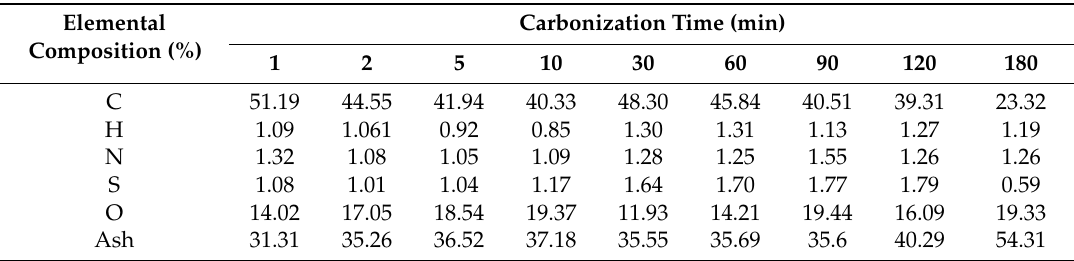
Table 2. Elemental composition of the ginkgo-leaf-derived biochars (GBs) produced under different carbonization times.